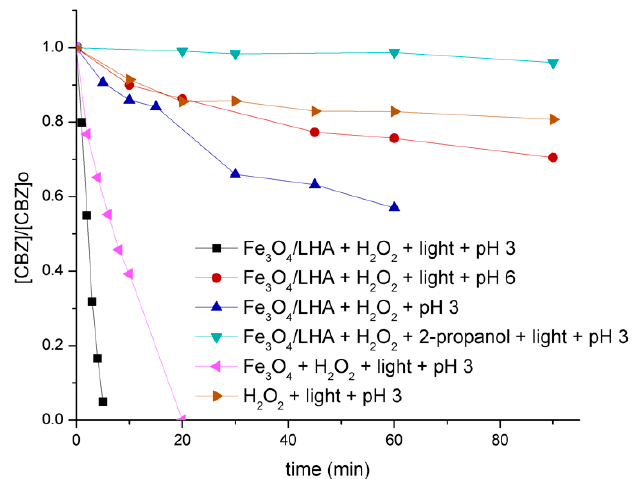
Figure 2. Normalized CBZ degradation under different experimental conditions. (CBZ) 0 = 2 mg L − 1 ; (Fe 3 O 4 / LHA) 0 = 500 mg L − 1 , (Fe 3 O 4 ) 0 = 500 mg L − 1 , (H 2 O 2 ) 0 = 0.15 mM, (2-propanol) 0 = 0.1 M when it is indicated.